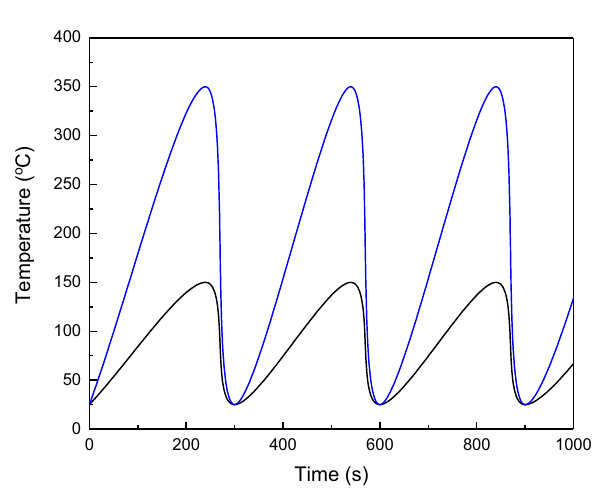
Figure 3. Thermal cycles at 150 and 350 °C versus